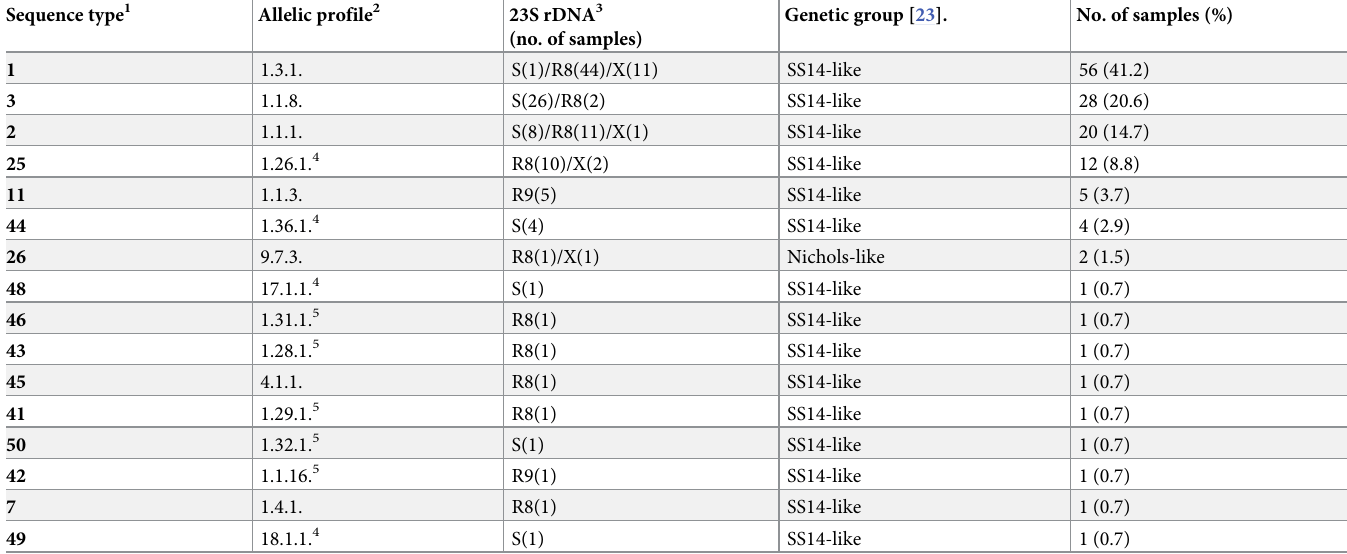
Table 2. Allelic profiles identified among fully-typed samples (n =